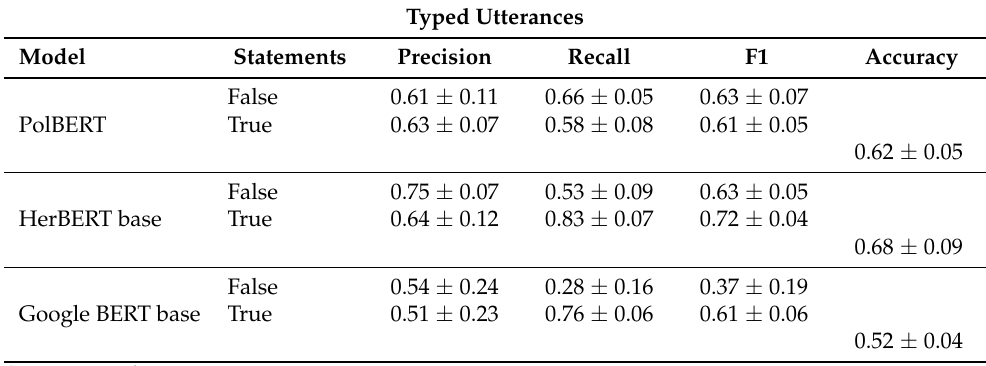
Table 2. Results of BERT models for typed utterances ( ± cross-validation standard